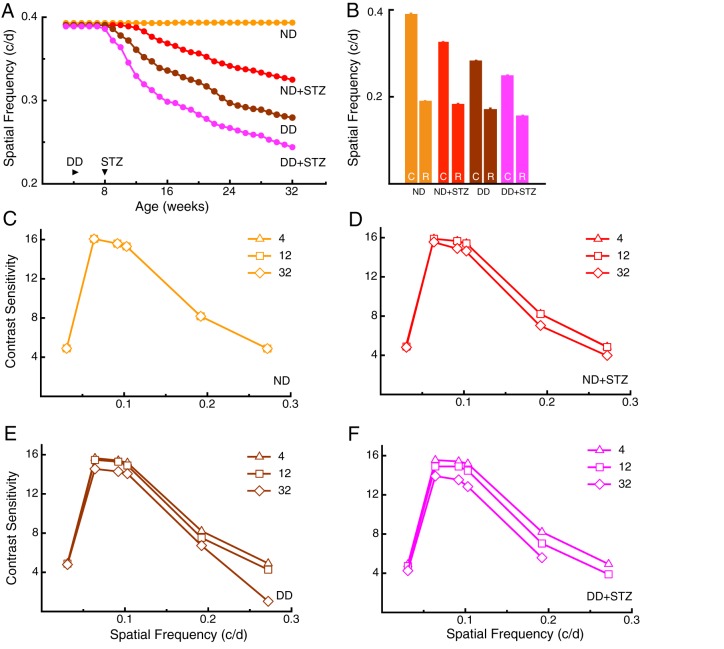
Progressive decline of visuomotor function in diabetic models. (A) SF thresholds under photopic (cone-mediated) conditions did not change in ND mice from 12 [0.393±0.006 c/d (n=7)] to 32 weeks [0.394±0.001 c/d (n=5), P>0.05]. Reduced thresholds (average of both eyes) emerged in ND+STZ mice at 12 weeks [0.387±0.003 c/d (n=12), P<0.05], with a 17% decline by 32 weeks [0.325±0.001 c/d (n=9), P<0.01]. Reduced thresholds emerged in DD mice by 9 weeks [0.386±0.002 c/d (n=7), P<0.01], with a 29% decline by 32 weeks [0.280±0.001 c/d (n=4), P<0.01]. A reduction emerged in DD+STZ mice at 8 weeks [0.327±0.001 c/d (n=6), P<0.01], with a 38% decline by 32 weeks [0.244±0.001 c/d (n=3), P<0.01]. (B) Cone-mediated function was more compromised than rod function in diabetic models at 28 weeks. As previously reported (Altimus et al., 2010), rod thresholds (photopic; R) are significantly lower (0.19225±0.000324 c/d) than cone (C) thresholds (0.3935±0.0006 c/d, P<0.01, n=4) in ND mice. Both rod and cone thresholds were reduced from normal in all diabetic models, with the most impairment in cone-mediated function: ND+STZ (cone versus rod: 0.331±0.0005 c/d versus 0.18624±0.0000342 c/d, P<0.01); DD (cone versus rod: 0.286±0.00634 c/d versus 0.17268±0.000325 c/d, P<0.01); DD+STZ (cone versus rod: 0.253±0.0000233 c/d versus 0.15813±0.000435 c/d, P<0.01). (C-F) Progressive decline of CS in diabetic models. (C) Normal CS was present in ND mice when measured at 4, 12 and 32 weeks. (D) CS in ND+STZ mice decreased moderately between 12 and 32 weeks at SFs above 0.06 c/d. (E) Decreased CS was evident at 12 weeks in DD mice and progressed by 32 weeks, particularly at the highest SF tested. (F) DD+STZ mice displayed the most dysfunction over time, such that by 32 weeks, they did not respond at the highest SF tested.